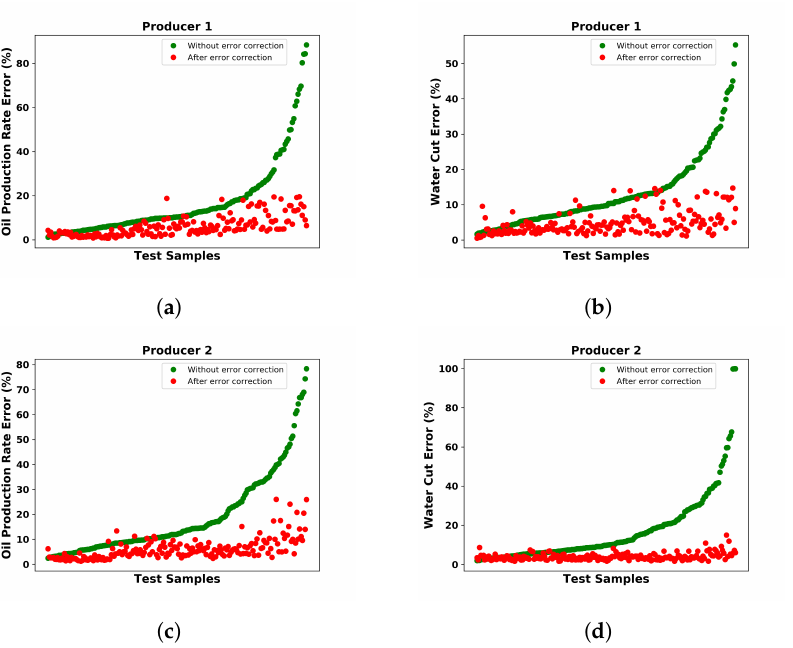
Figure 52. Error in the prediction of ( a ) the oil production rate and ( b ) water cut for producer 1 and ( c ) oil production rate and ( d ) water cut for producer 2 for all the test cases before and after the error correction of the